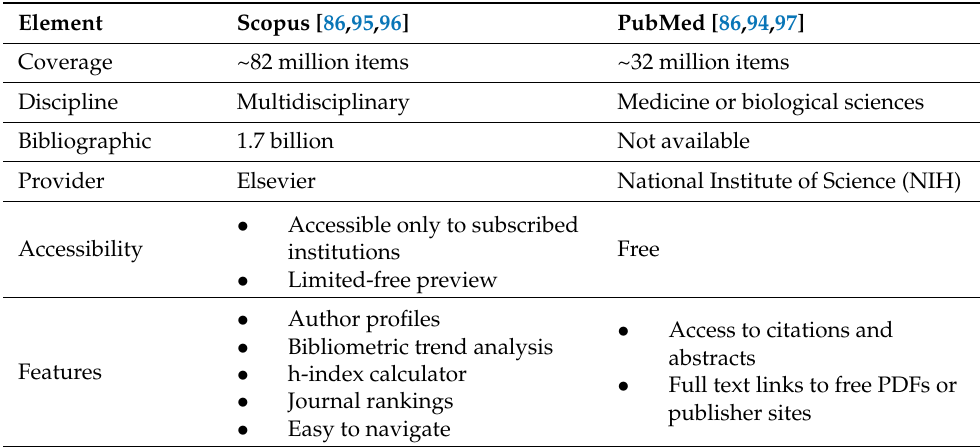
Table 3. Features and accessibilities of both Scopus and PubMed scholarly databases for bibliomet- ric